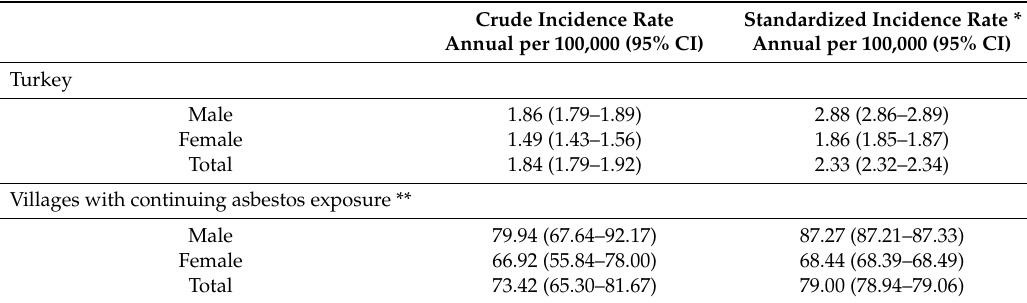
Table 2. Crude and standardized mesothelioma incidence rates.